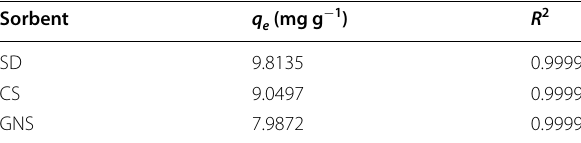
Table 6 q and R 2 values obtained for SD, CS and GNS from e pseudo second order model Sorbent